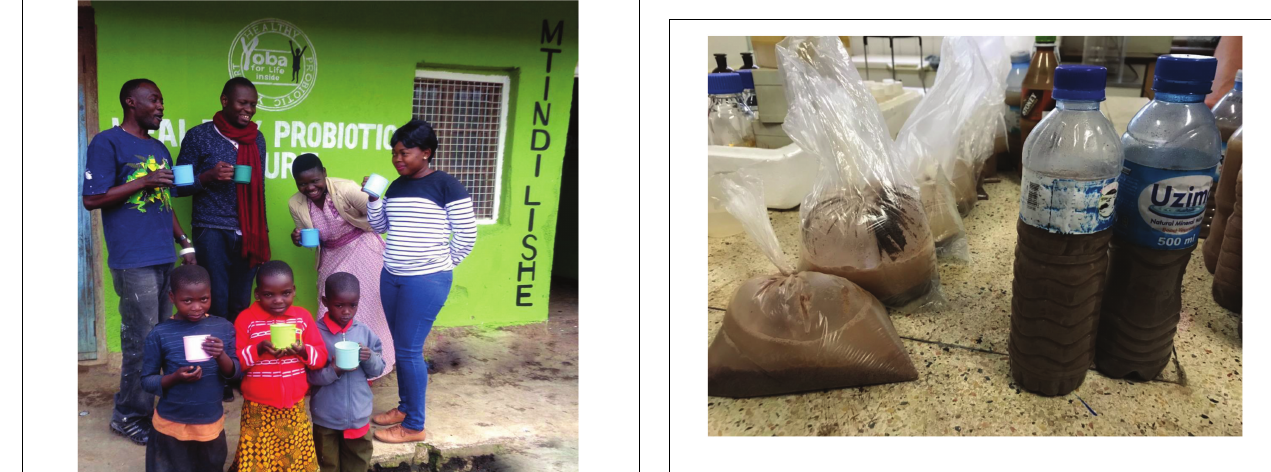
FIGURE 2 | Samples of Obushera (fermented millet) sold in the streets of Kampala, Uganda, and shown in Dr. Ivan Mukisa’s lab at Makerere University, to be